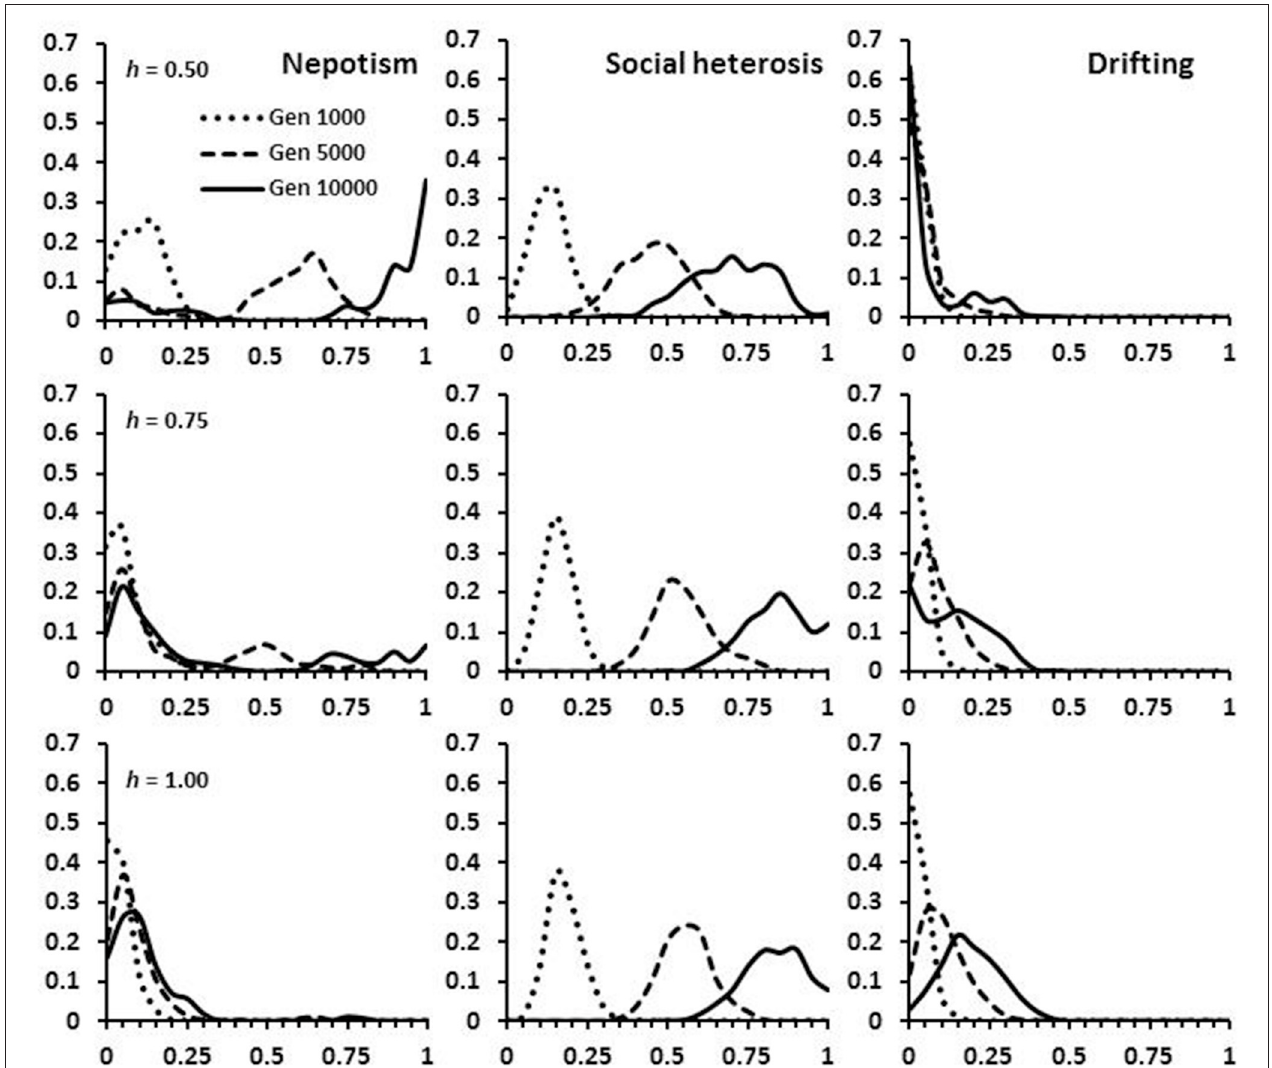
FIGURE 4 | Frequency of alleles at the expression loci for nepotism, social heterosis and drifting. The distributions are given at time periods 1,000, 5,000, and 10,000 in the simulations. The three panels show the effects on allele distribution as selection goes from favoring monandry and high relatedness ( h = 0.50), to favoring polyandry, drifting and low relatedness ( h =